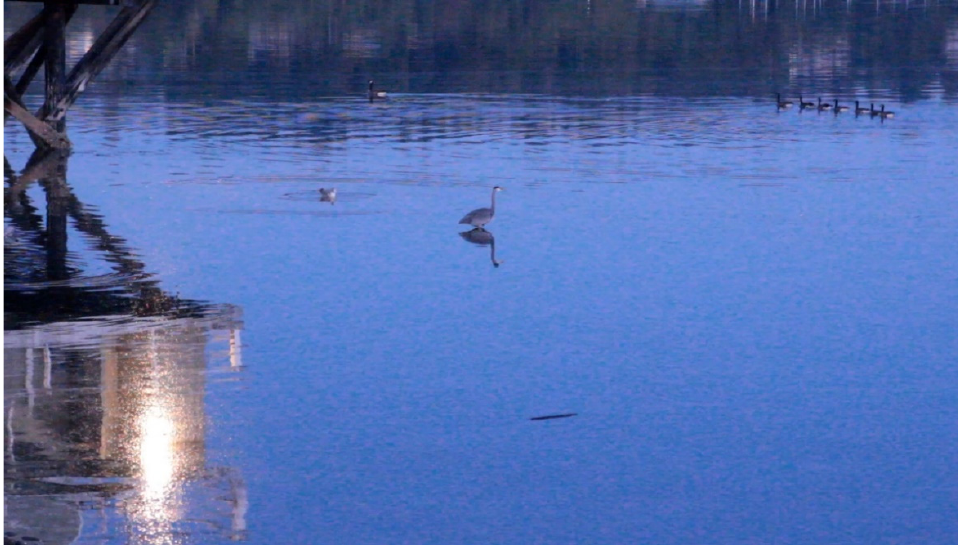
Figure 2. Waking in Real Time (2018). Digital film still. https://vimeo.com/showcase/9841426/video/308935653 (accessed on 26 September 2022).